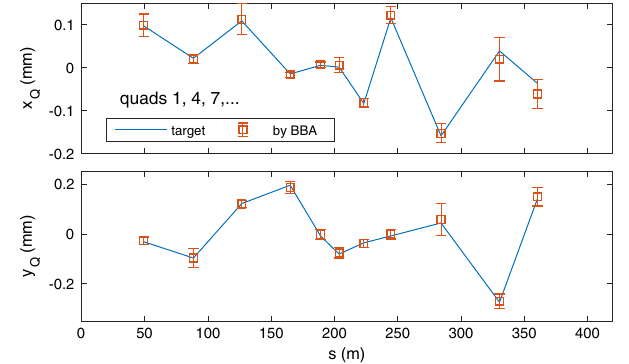
FIG. 5. The quadrupole offsets found with the PBBA method, with BPM error sigma at 5 μ m.